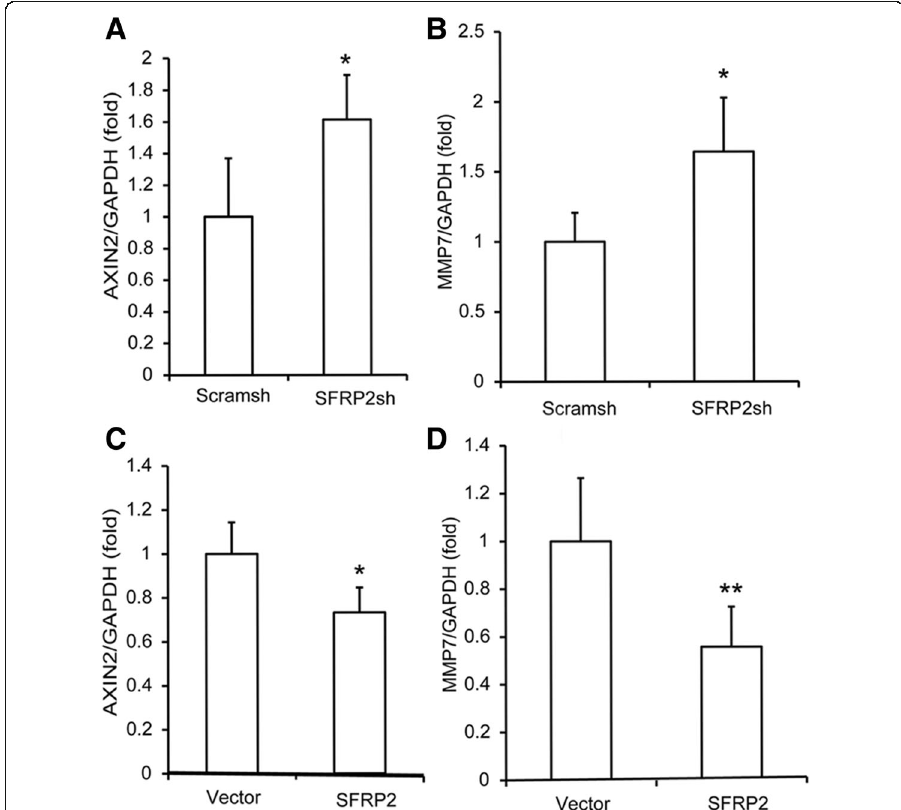
Fig. 4 SFRP2 decreased the expression of Wnt target genes in SCAPs. a , b Real-time RT-PCR showed that the depletion of SFRP2 upregulated the expression of AXIN2 and MMP7 . c , d Real-time RT-PCR results showed that the overexpression of SFRP2 decreased the expression of AXIN2 and MMP7. Student ’ s t test was performed to determine statistical significance. All error bars represent SD ( n = 3). * p ≤ 0.05, ** p ≤